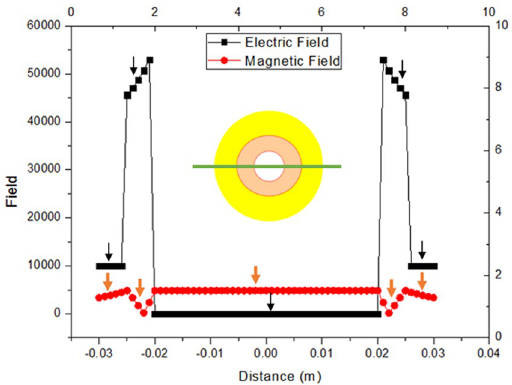
Figure 4. The distributions of the electric field and induced magnetic field in the center line (y = 0, z = 0, green line in insert). The five black segments (indicated by black arrows) are the distributions of the electric field and the five red segments (indicated by red arrows) are the distributions of the induced magnetic field. The electric field and induced magnetic field are symmetry about x = 0, the electric field and the magnetic field are not continuous on the boundaries x = ± 0.025 m, x = ± 0.020 m, x = ± 0.010 m. The magnetic fields are 50000 times actual magnetic